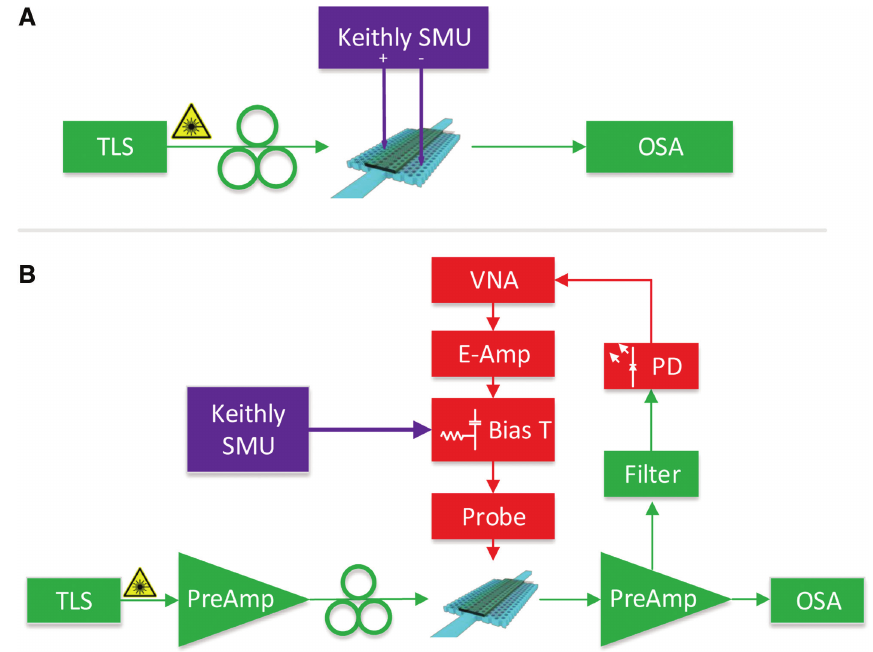
Figure 6: (A) Setup for measuring modulation depth: measuring modulation depth by changing DC source; (B) setup for measuring frequency